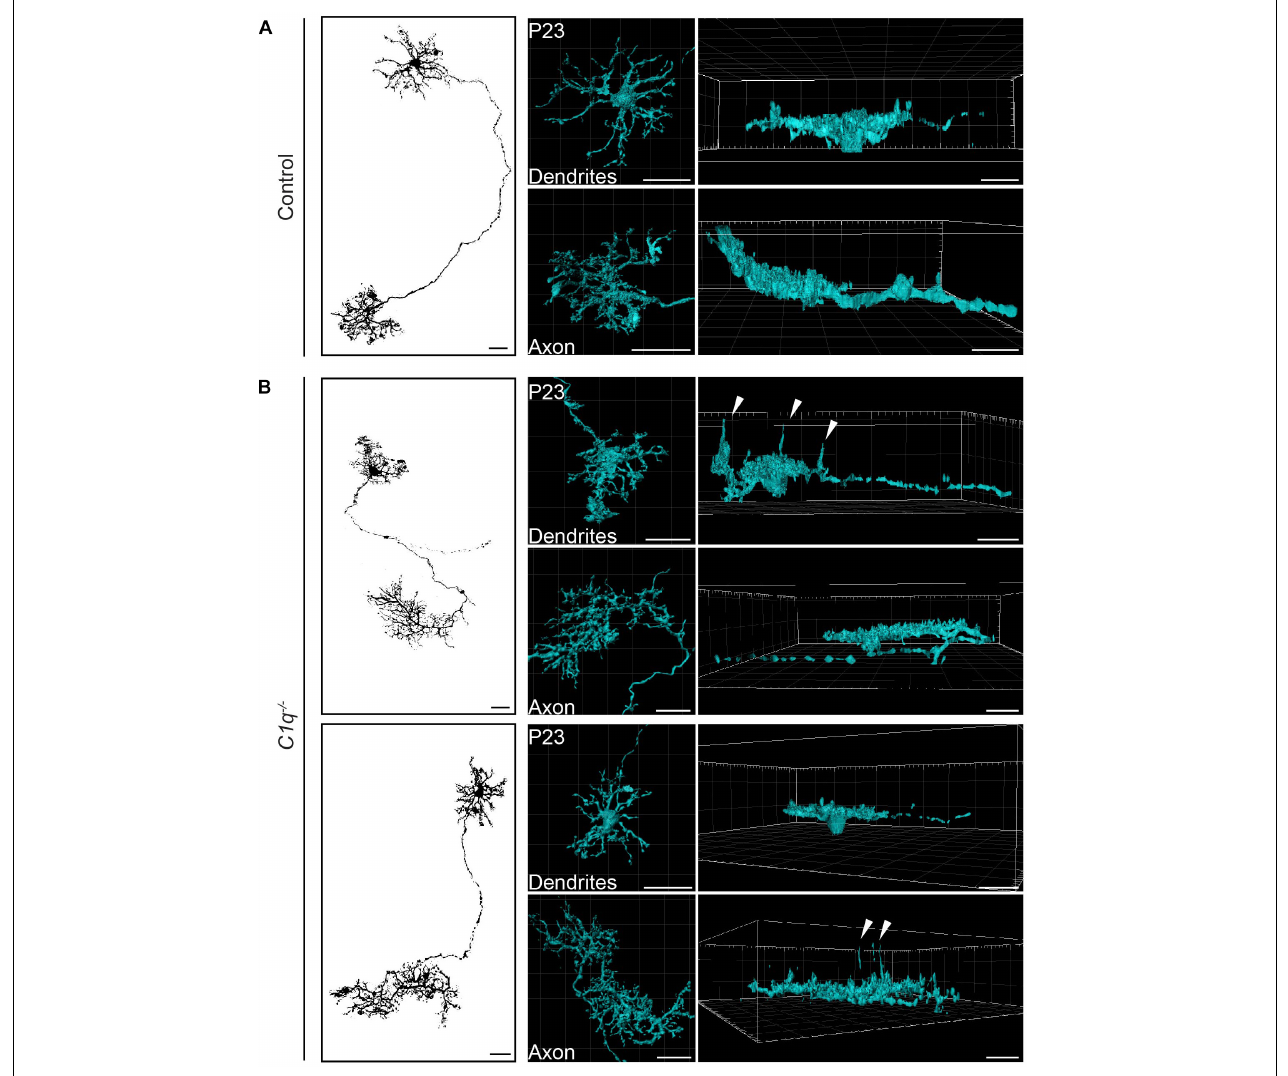
FIGURE 2 | C1q confines subsets of horizontal cell neurites within axons and dendrites. Representative single AAV-labeled horizontal cells from wild type control ( A ) and C1q − / − ( B ) mice were reconstructed at P23. An en face image of each horizontal cell (left panel) is shown together with the individual reconstruction of that cell’s axon and dendrite presented in an en face (middle panel) and lateral view (right panel). Subsets of neurites from both axons and dendrites extend ectopically in the C1q − / − mice (arrowheads), while no such neurite extensions were observed in controls. n = 4 horizontal cells each from three wild type control and three C1q − / − mice, respectively. Scale bars = 25 µ